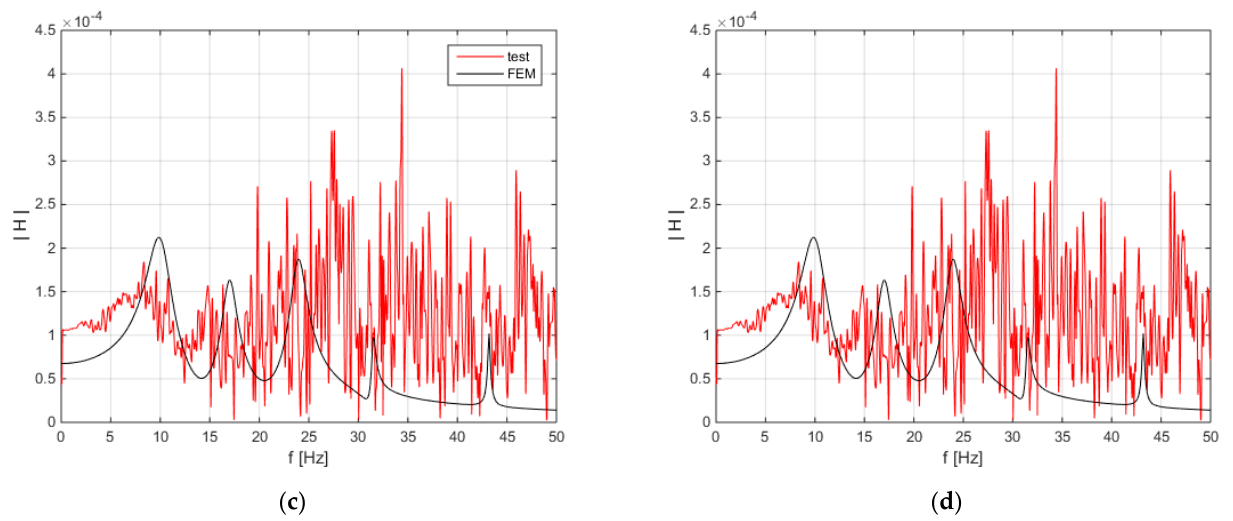
Figure 7. Frequency response functions of the calibrated FE models vs. the experimental data for test phases 1 to 4 from ( a – d ) respectively.